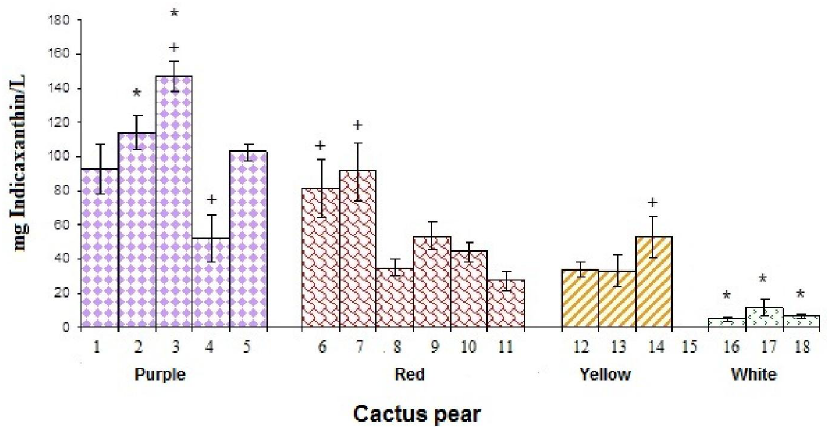
Figure 2. Betaxanthin content of cactus pear studied cultivars. * denotes statistical significance at p < 0.05 among all studied cultivars of cactus pears. + indicates statistical significance at p < 0.05 among the cultivars of cactus pears in the same color.